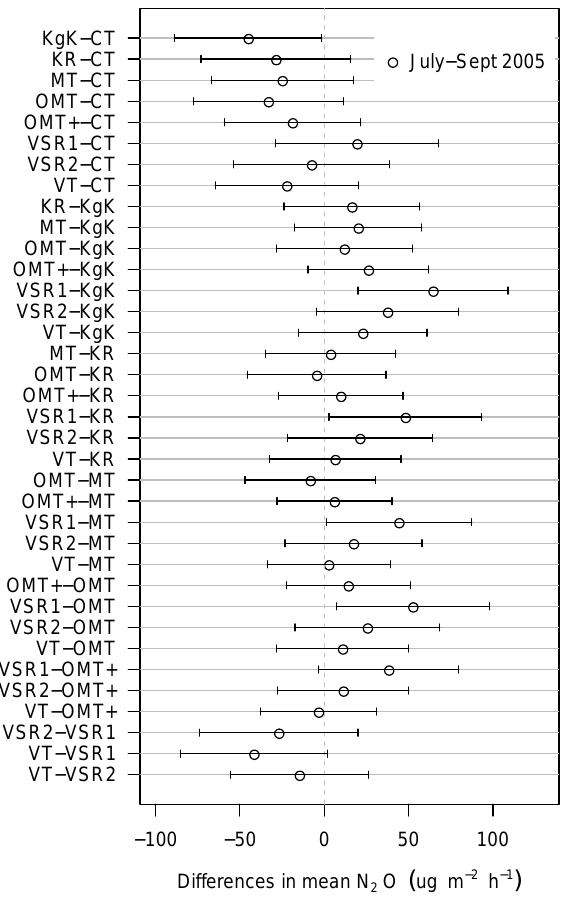
Figure 9. The post hoc Tukey differences (error bars for 95% con- fidence intervals) of mean N 2 O (µgm − 2 h − 1 ) fluxes from the forest floor for the pairwise comparisons of forest/mire types (uplands – CT, VT, MT, OMT; transitions – OMT + , KgK, KR; and mires – VSR1, VSR2) over the period of the soil water sampling campaign (July–September